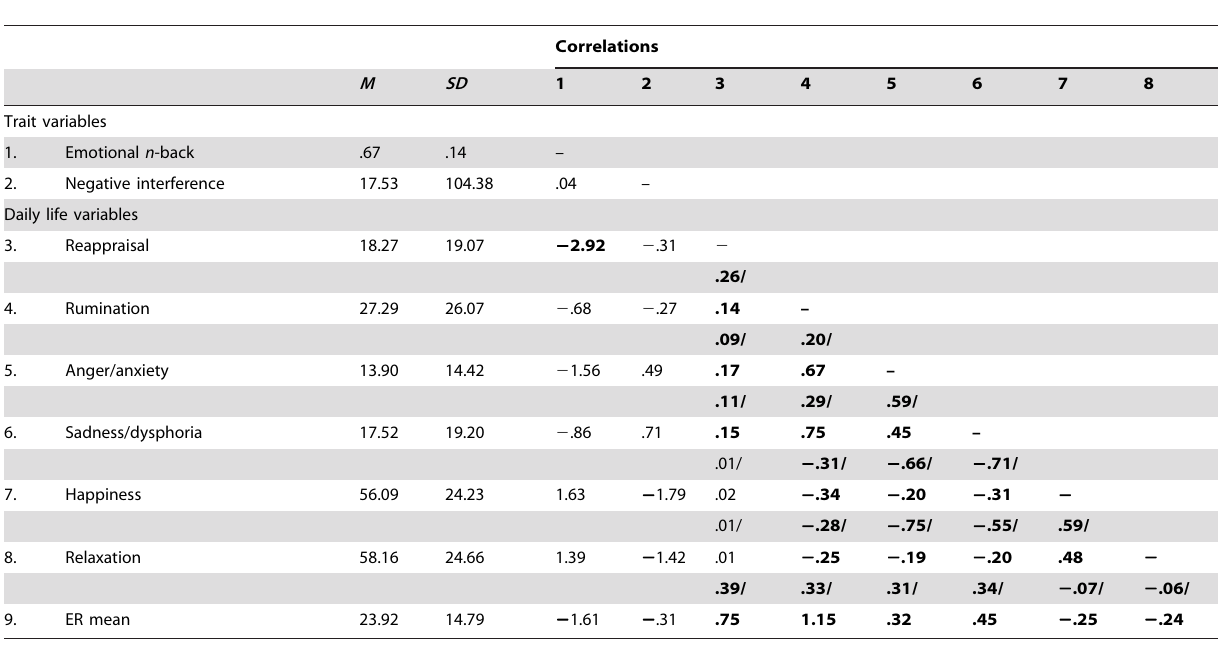
Table 3. Descriptive Statistics and Relationships of Different Variables in Study